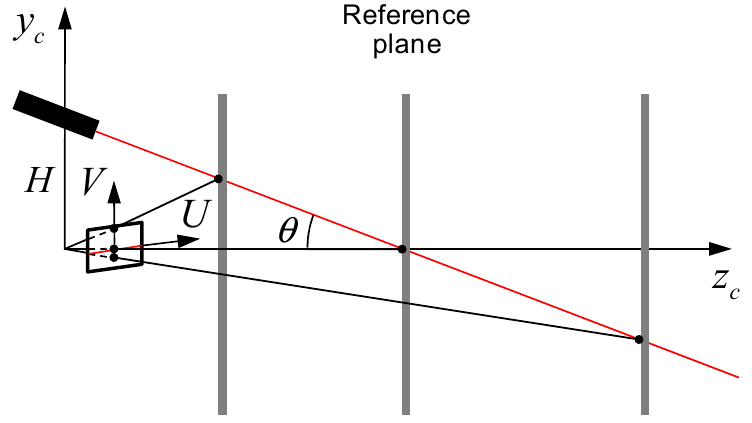
Figure 3. The geometric relation between a 3D illuminated laser point and its 2D image